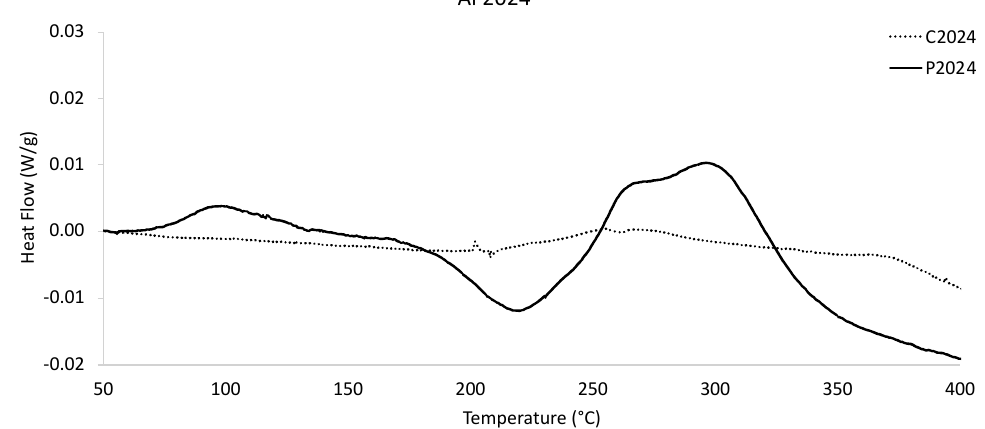
Figure 5. Differential scanning calorimetry-derived heat flow versus temperature curves for the as-cast as well as the as-atomized Al 2024 materials.